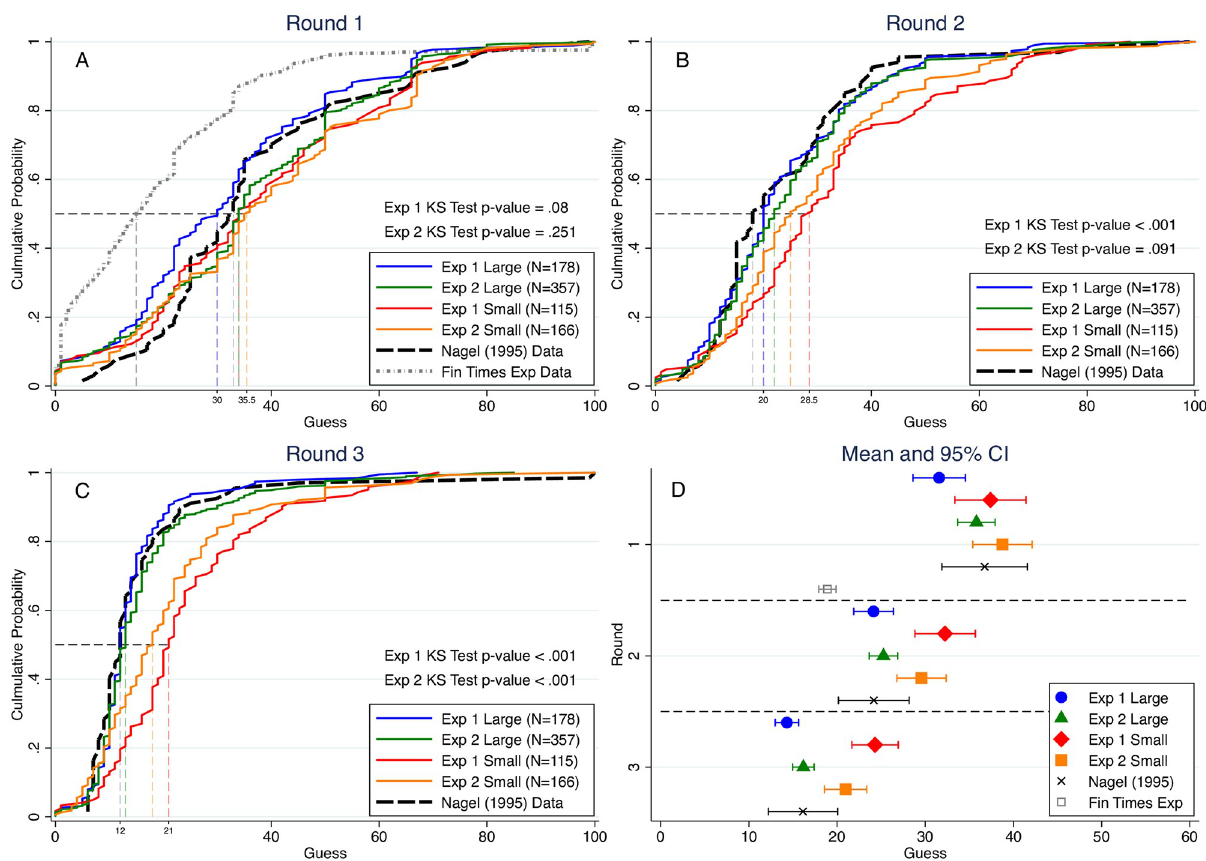
Fig 1. Cumulative density function of guesses across different rounds. (A-C) The distribution of guesses in large groups and small groups from Experiments 1 and 2 as well as from [21, 22]. The numbers of observations are shown in the legends and the median guesses of large and small groups are labeled in dashed lines. The p -values of the Kolmogorov–Smirnov tests for different groups are provided at the bottom of each figure. (D) The means and 95% CI for different groups from round 1 to round 3.